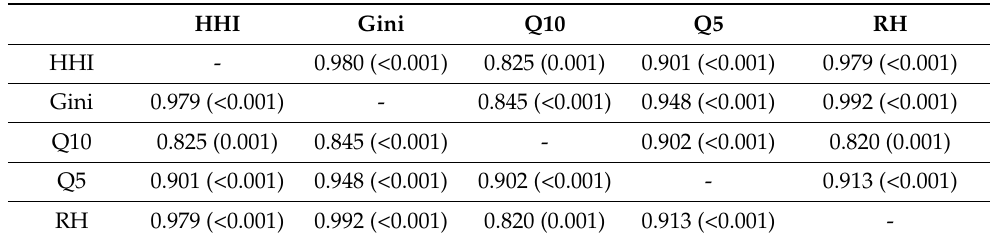
Source: own calculation. Table A5. Correlation (and p -value) of sports expenditure inequality indices between 2005 and 2017, all households.